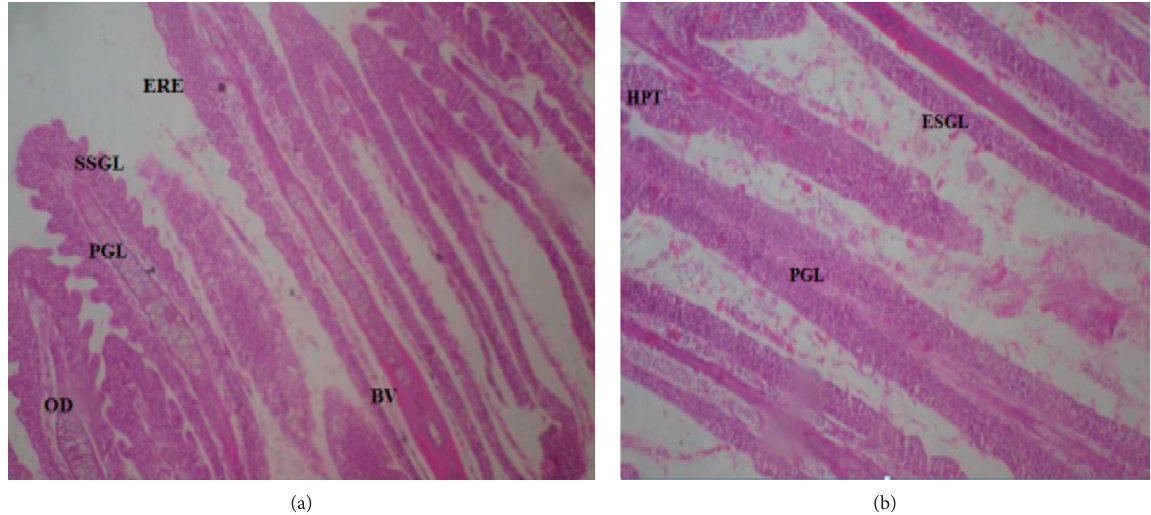
Figure 5: (a) Histological section of gill exposed to nano-SiO/CuO (1:1) showing primary gill lamella (PGL) shortened secondary gill lamella (SSGL), blood vessel, oedema of primary lamella, and eroded epithelium (H&E stains, × 100). (b) Histological section of gill exposed to nano-SiO/Al 2 O 3 (1:1) showing primary gill lamella (PGL), eroded secondary gill lamella (ESGL), and hypertrophy (HPT) (H&E stains, × 100).